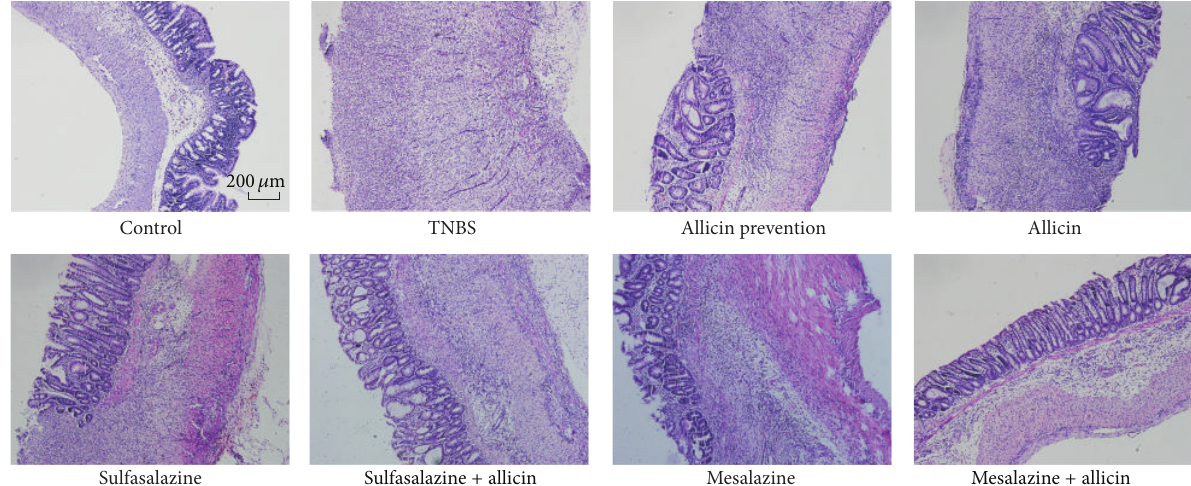
Figure 2: Histological photographs of H&E stained colon after 2-week treatments (100 × ). TNBS-induced rats had severe colitis with deep ulceration, transmural leukocyte infiltration, loss of goblet cells, and thickening of intestinal walls. Different treatments relieved colitis in various degrees. Sulfasalazine and mesalazine + allicin made the colons basically